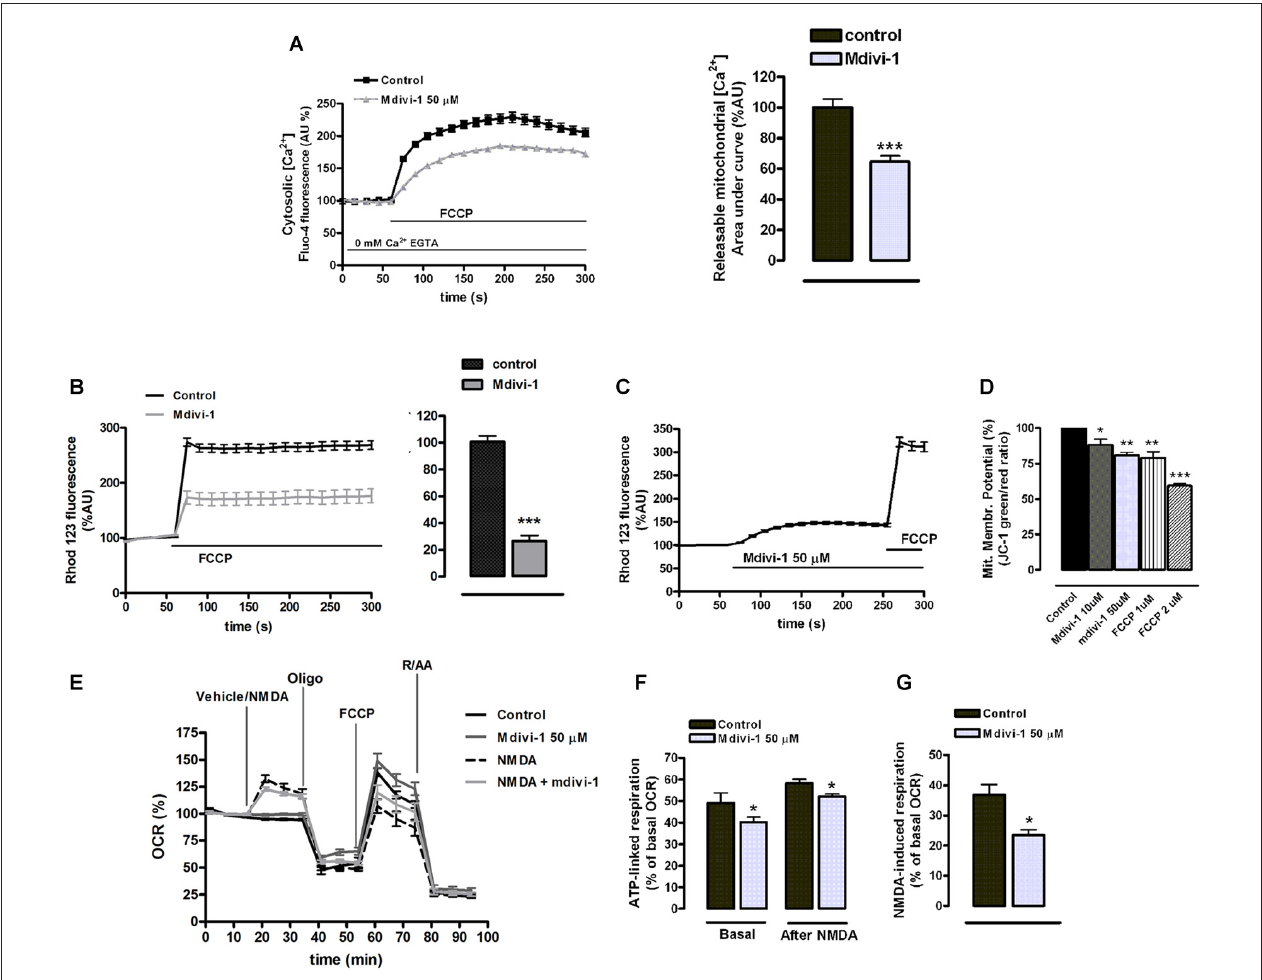
FIGURE 7 | Mdivi-1 regulates mitochondrial [Ca 2 + ], membrane potential and respiration. (A) Neurons were incubated with Fluo-4 in a Ca 2 + -free medium containing EGTA and exposed to FCCP (1 µ M) in the presence or absence of mdivi-1 (50 µ M). Resulting cytosolic Ca 2 + increase was measured to determine FCCP-releasable [Ca 2 + ] mit . Traces represent normalized means ± SEM of control ( n = 74) and mdivi-1-treated cells ( n = 77) from at least three independent cultures. ∗∗∗ p < 0.001 compared to control cells, Mann-Whitney U test. (B,C) Cells were incubated with quenching concentrations (5 µ M) of rhodamine 123 and exposed to FCCP and the increase in fluorescence was measured to determine mitochondrial membrane potential. (B) Traces represent normalized means ± SEM of control ( n = 86) and 10 µ M of mdivi-1-treated ( n = 55) cells from at least three independent cultures. ∗∗∗ p < 0.001 compared to control cells, Mann-Whitney U test. (C) Traces represent normalized means ± SEM of rhodamine 123 fluorescence from neurons sequentially treated with mdivi-1 (50 µ M) and FCCP (1 µ M). (D) Mitochondrial membrane potential was measured using JC-1 fluorescent dye 45 min after 10 µ M ( n = 5) and 50 µ M ( n = 4) of mdivi-1 application or 15 min after 1 µ M ( n = 4) and 2 µ M ( n = 3) of FCCP addition. Data represent normalized means ± SEM of the JC-1 red/green fluorescence ratio. ∗ p < 0.05, ∗∗ p < 0.01, ∗∗∗ p < 0.001 compared with control (untreated cells), paired Student’s t -test. (E–G) Primary neurons in the presence or absence of mdivi-1 (50 µ M, 1 h) were exposed to vehicle or NMDA (30 µ M), oligomycin (2 µ M), FCCP (1 µ M) and rotenone plus antimycin A (both 0.5 µ M) and mitochondrial oxygen consumption rate (OCR) measured. Traces represent normalized means ± SEM of n = 5 experiments. ATP-linked respiration (F) and NMDA-stimulated respiration (G) are represented as a percentage of the basal OCR. ∗ p < 0.05 compared with control (untreated cells or NMDA alone), paired Student’s t